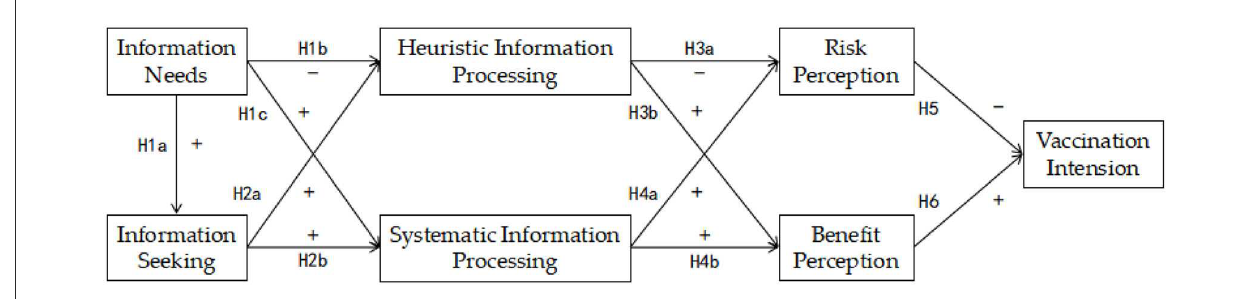
FIGURE1 The conceptual research model. Hypothesis: H1–H6. “ + ” means positive effect, “–” means negative effect. The arrows point to the affected variables.